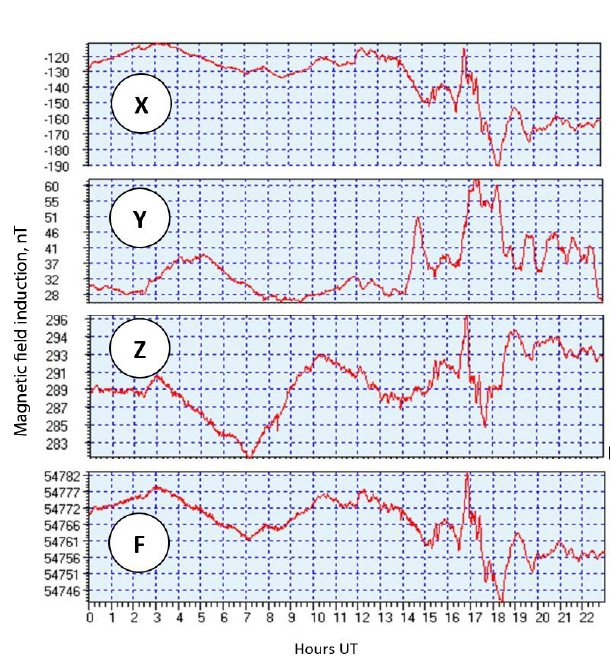
Figure 7. The intensity of the geomagnetic field at the Alma-Ata observatory on 20 January 2010. The X , Y , and Z components and full field ( F ) are shown.